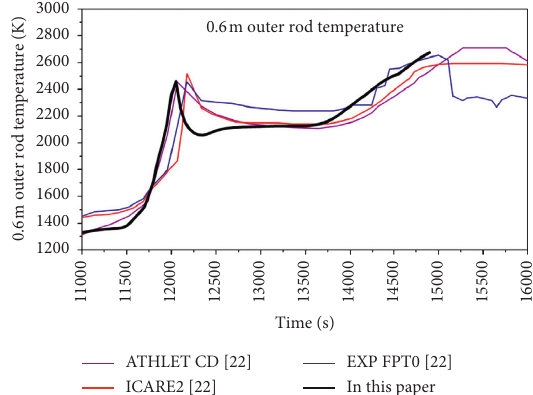
Figure 16: Variation of outer ring fuel rod temperature at